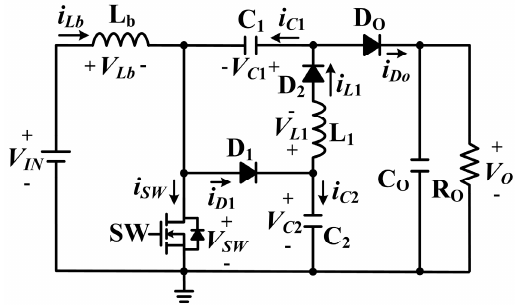
Figure 2. Schematic of proposed DC–DC boost converter.